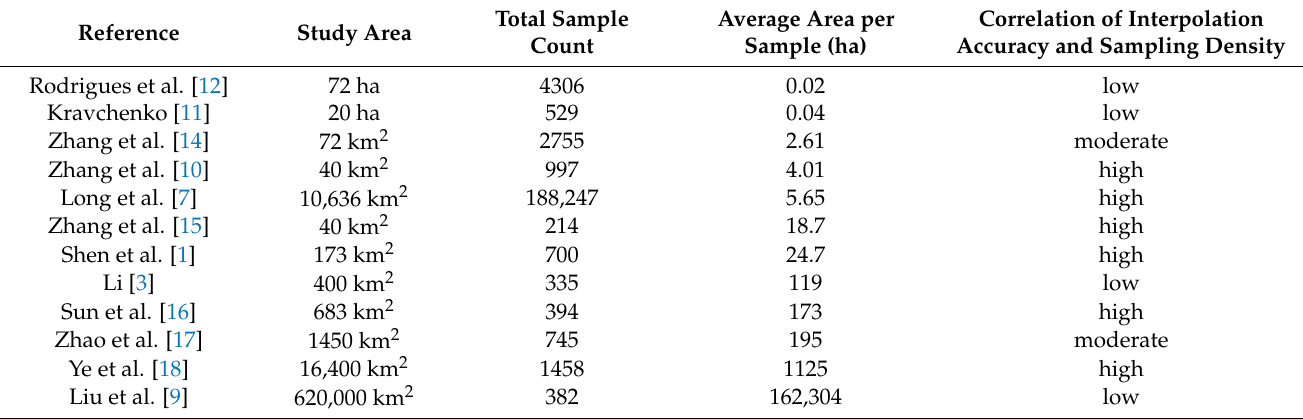
Table 1. Literature review of the effect soil sampling density in agricultural land has on spatial interpolation accuracy.